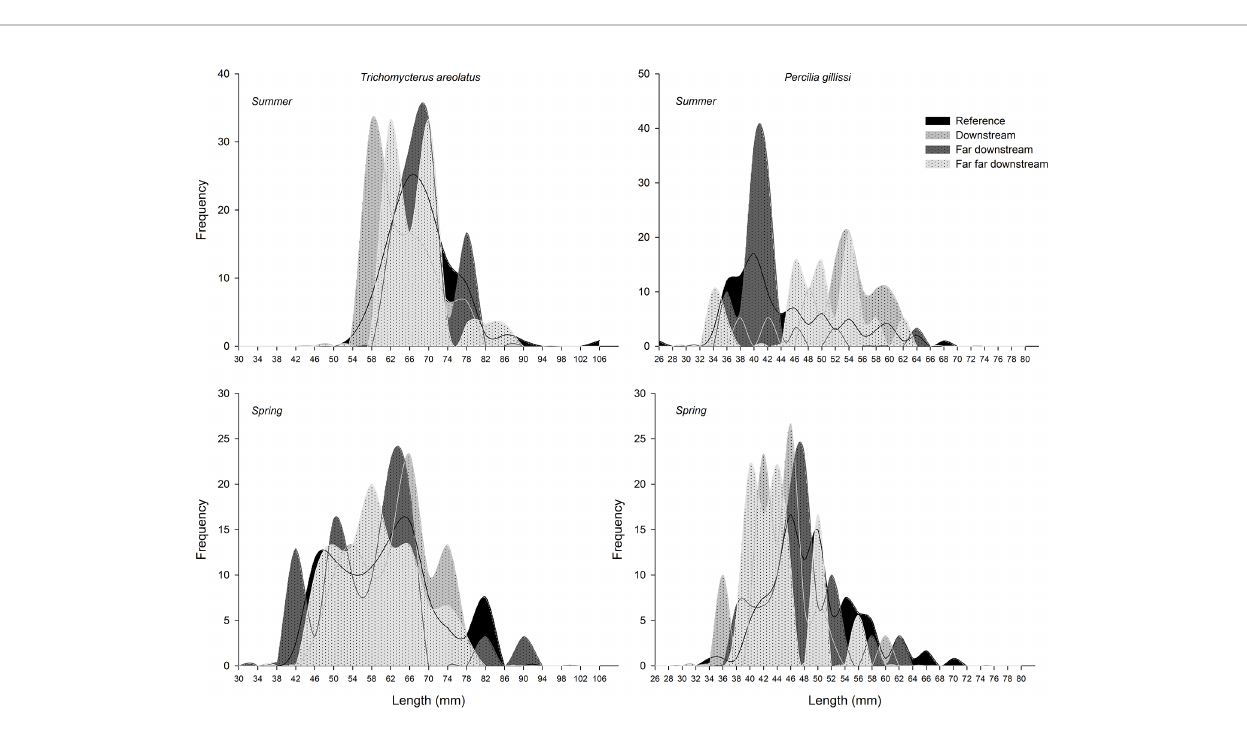
FIGURE 7 | Changes in the fi sh size frequency between upstream and downstream Elemental Chlorine Free-PPME discharge